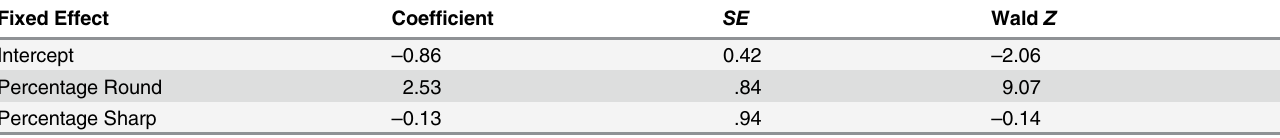
Table 5. Summary of the logistic regression predicting the likelihood of a name being